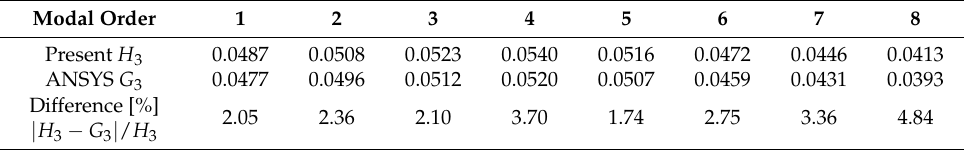
Table 5. The comparison of the first eight modal loss factors of the FCTS obtained by theoretical calculations and the finite element